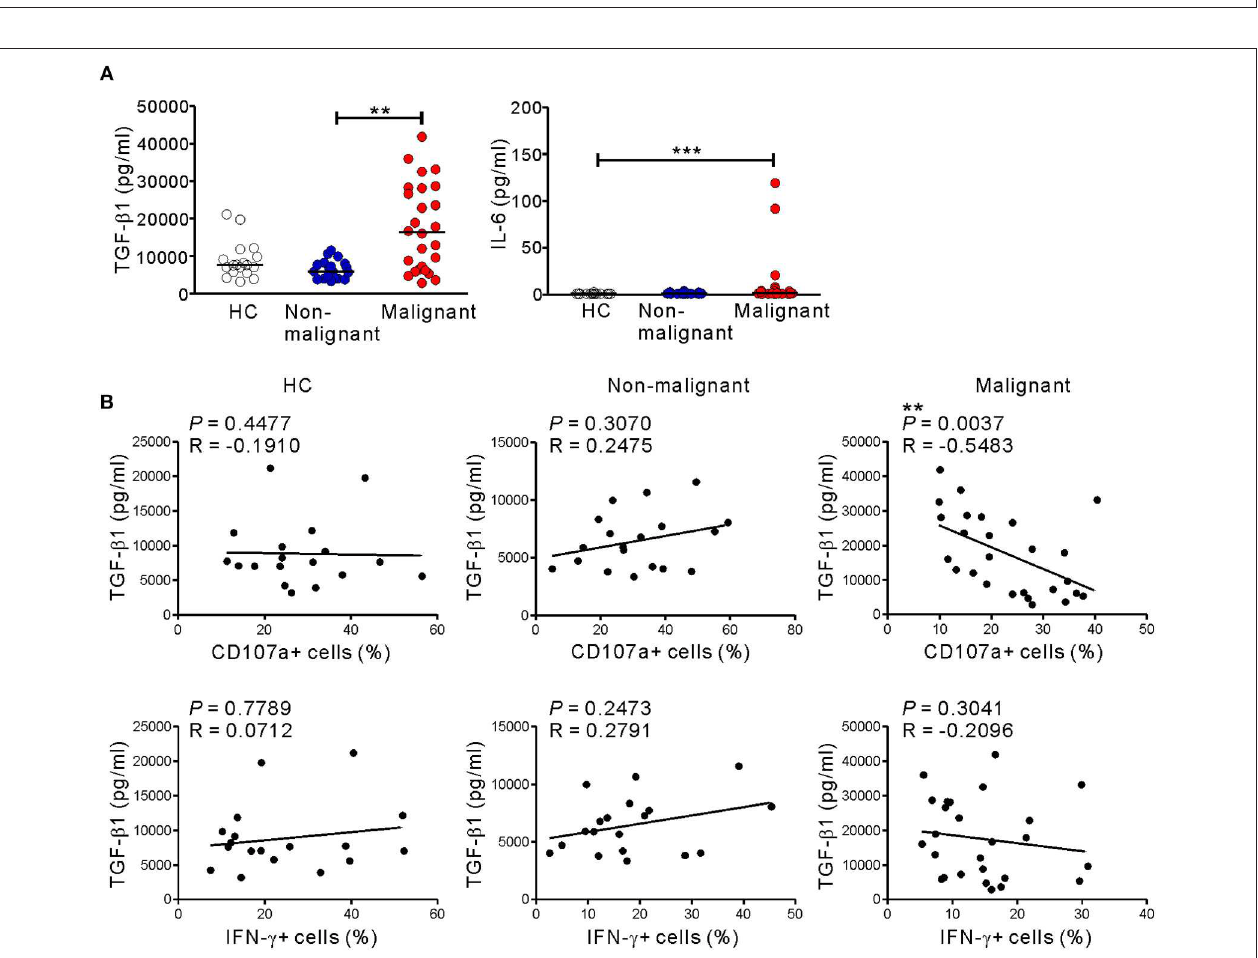
FIGURE 7 | Correlation between the level of TGF- β 1 and impaired NK cytotoxicity in PC patients. (A) The plasma levels of TGF- β 1 and IL-6 were measured by Luminex multiplex assay. Plasma levels of the indicated cytokines in the healthy control (HC) group ( n = 18), the non-malignant group ( n = 19), and the malignant group ( n = 26). Horizontal bars denote the medians. (B) Plasma TGF- β 1 levels in the malignant group correlated inversely with the percentages of CD107a-positive NK cells after stimulation with P815-ULBP1 + CD48 cells. ** P < 0.01 and *** P < 0.001; Kruskal-Wallis with Dunn’s test (A) and Spearman’s correlation test